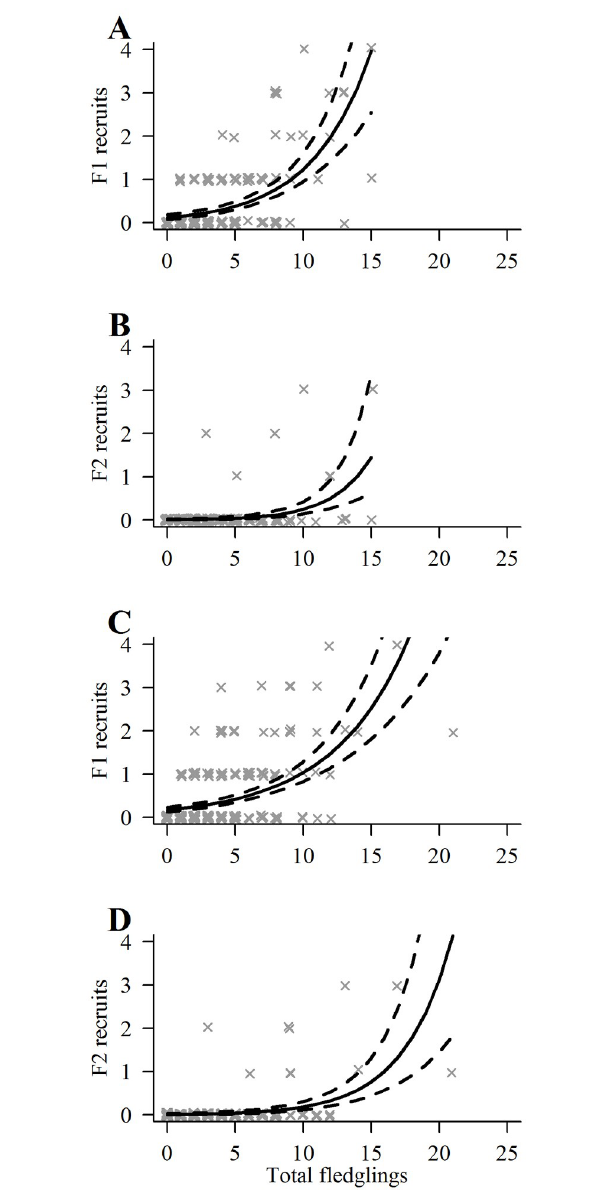
Fig 13. Number of children and grandchildren that locally recruited as breeders in relation to the number of fledglings produced by individual male and female goshawks. Number of banded descendants of 196 male (A, B) and 250 female (C, D) northern goshawks that recruited into the local breeding population as children (F1 generation) and grandchildren (F2 generation) in relation to the number of fledglings each breeder produced in Arizona, USA. Each ‘x’ represents an individual adult. Trend lines determined with Poisson regression with log-link functions. Territory-specific reproduction: Breeding attempts, breeders, and mates. Our chi- square goodness-of-fit test for random vs. preferential nesting within 79 territories monitored for at least 18 years showed that goshawks occupied territories non-randomly across years ( X 2 ¼ 126 : 35 , P < 0.001); some territories appeared to be occupied preferentially while others 5 were avoided (Fig 14). The range in percent of years in which breeding occurred on the 79 ter- ritories was highly variable (5–89%, � x ¼ 39% � 0 : 02 , median = 4.5) as was the 18-year total